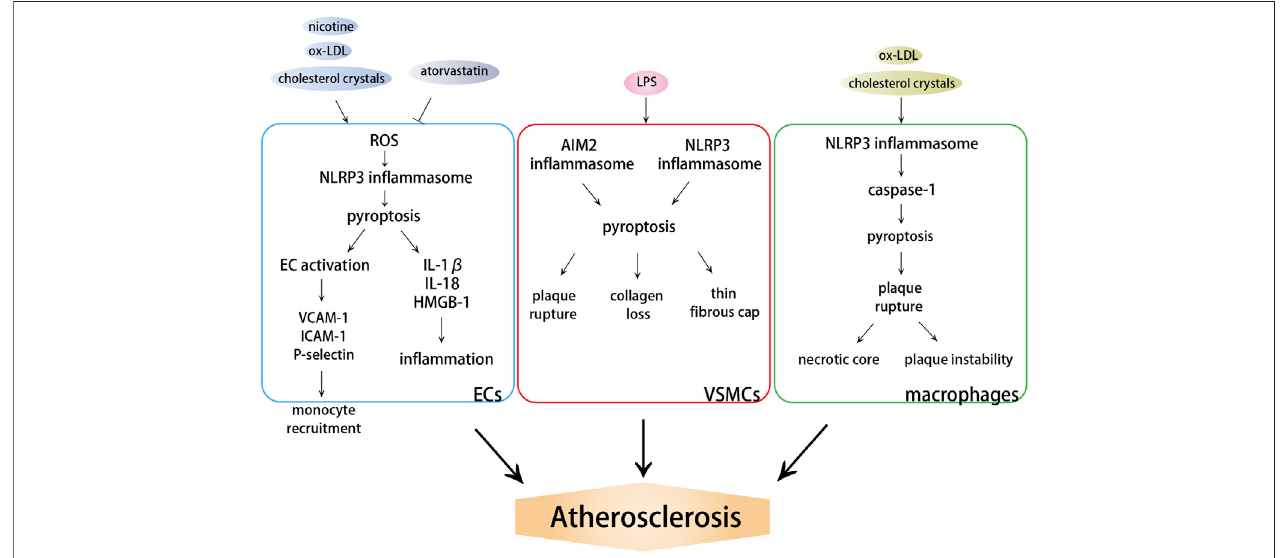
FIGURE 2 | Effects of pyroptosis on atherosclerosis. DAMPs induce the activation of NLRP3 or AIM2 in fl ammasome, which further activate caspase-dependent pyroptosis.ECspyroptosistriggersmonocyterecruitmentintotheintimainearlyatherogenesis.VSMCpyroptosisweakens fi brouscapsandcontributestopathological instability in atherosclerosis. Macrophage pyroptosis promotes the formation of necrotic core and aggravates plaque instability in advanced atherosclerotic lesions.